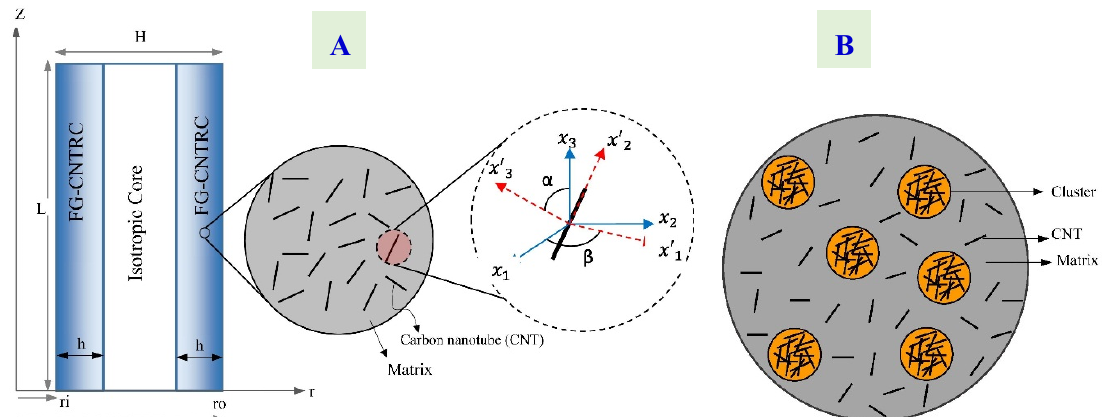
Figure 13. Schematic representation of nanocomposite cylinder with functionally graded (FG) distribution along with CNT coordinates ( a ), and representative volume element (RVE) with Eshelby cluster model of agglomerated CNT ( b ) [42].